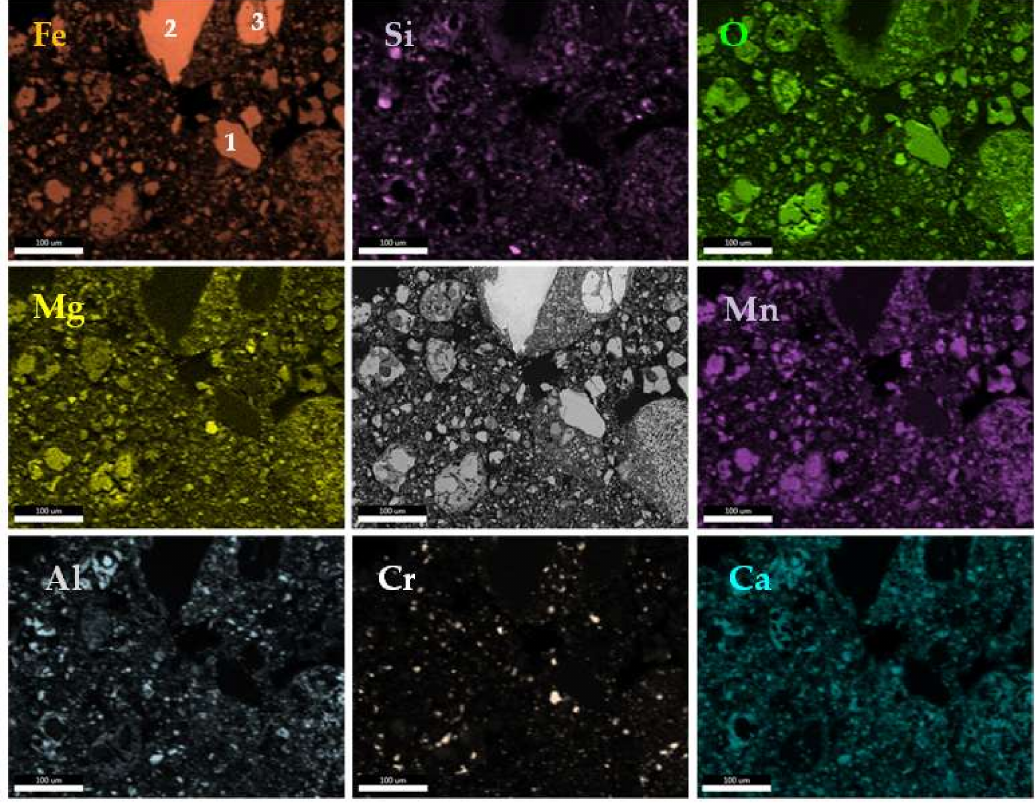
Figure 7. Distribution of some chemical elements in the magnetic fraction of the size fraction +0.25–1 mm determined by EDS 2D mapping in SEM